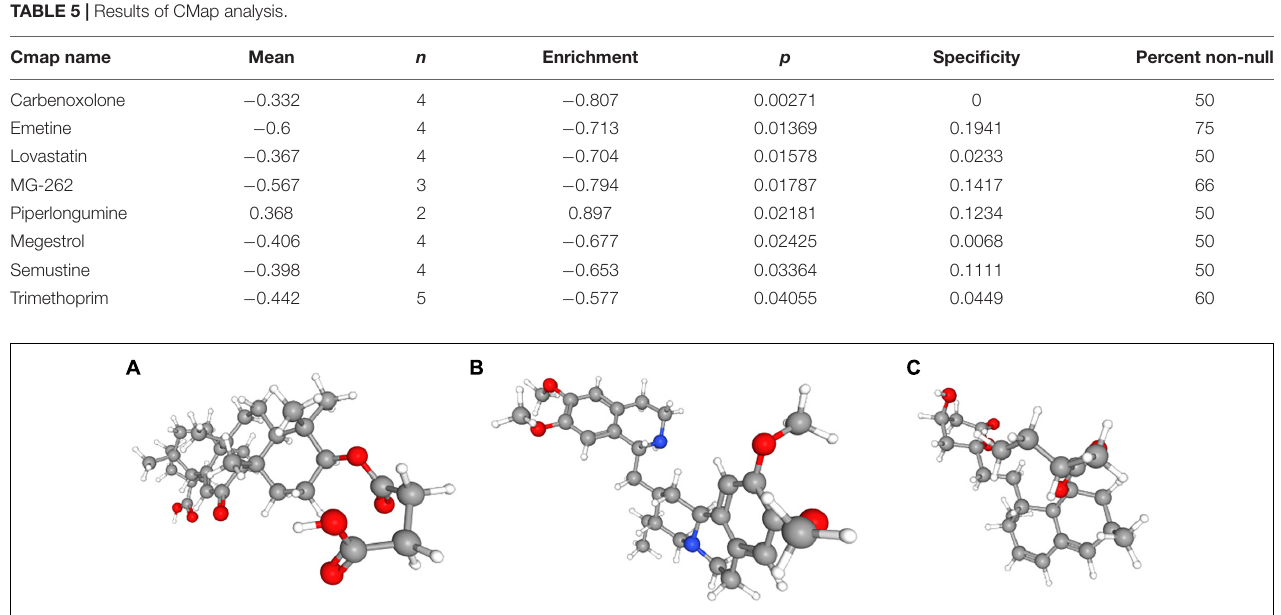
FIGURE 11 | Chemotherapeutic response in the high-risk and low-risk groups. *0.01 ≤ P < 0.05; **0.001 ≤ P < 0.01; *** P < 0.001. TABLE 5 | Results of CMap analysis.